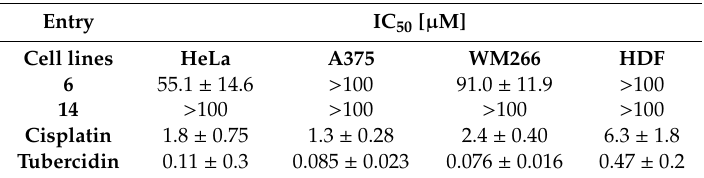
Table 2. IC 50 values obtained after 72 h incubation with the examined compounds on HeLa, A375, WM266 and HDF cell lines.